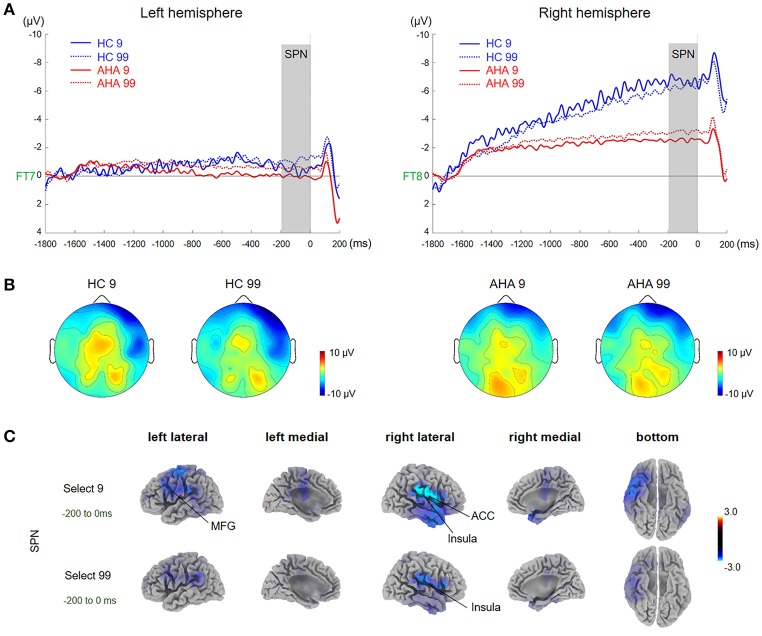
Waveforms and scalp topographies of SPN. (A) Grand average ERP waveforms following low- and high-risk decision-making for AHAs and HCs at FT7 and FT8; the shaded areas depict the time window of stimulus-preceding negativity (SPN). (B) Topographic maps of the mean amplitude of SPN (−100 to 0 ms). (C) The t-score maps for comparing AHAs and HCs for the SPN component for low- and high-risk options. The brain regions labeled with yellow/red indicate AHAs > HCs, whereas green/blue indicates AHAs < HCs. The time periods for SPN are also indicated. Significant brain regions (p < 0.05, FWE corrected) are shown on the map. The peak MNI coordinate regions for each comparison are reported in Table 1. ACC, anterior cingulate cortex; MFG, middle frontal gyrus.